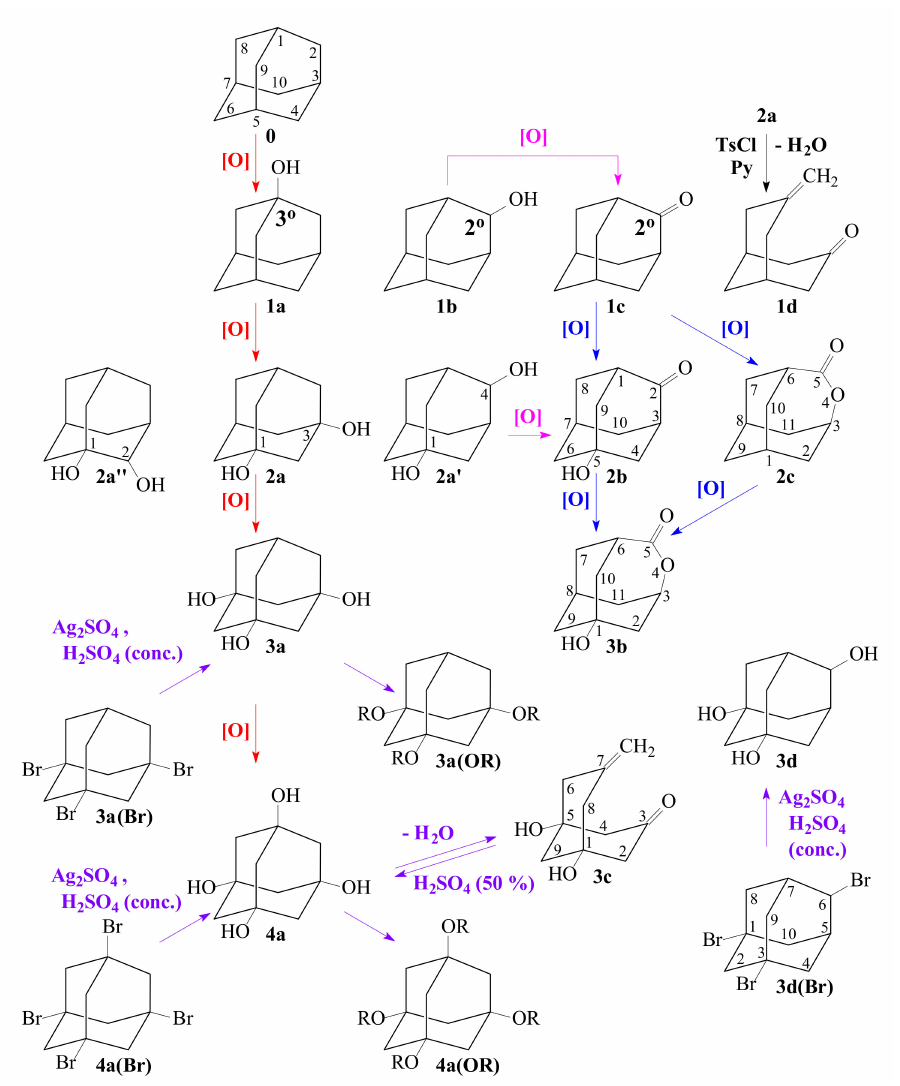
Scheme 1. Products of 0